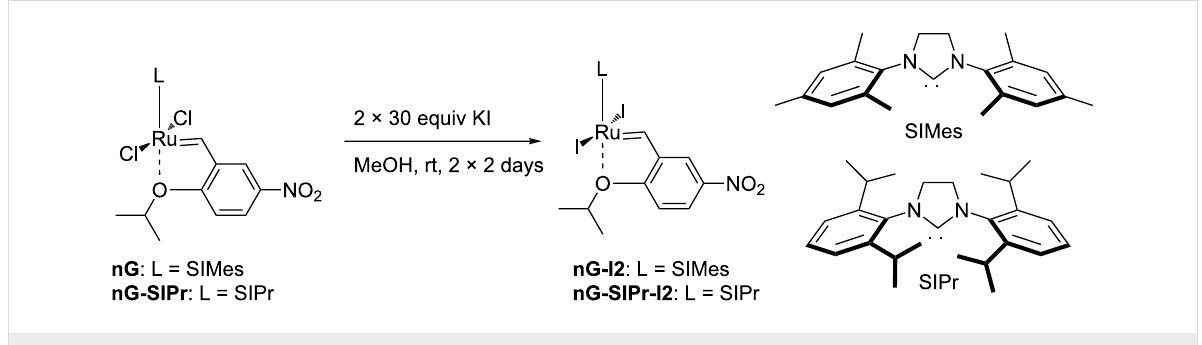
Scheme 2: Synthesis of iodide-containing nitro-Grela type catalysts.